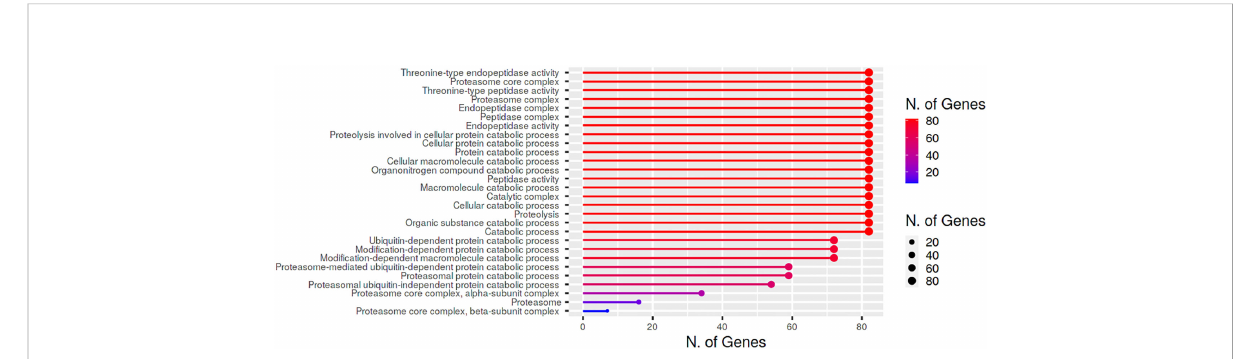
FIGURE 6 Cellular location and biological/molecular functions of BnPA/BnPB proteins in Brassica napus